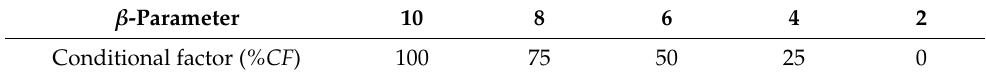
Table 3. Correlation between shape parameter and conditional